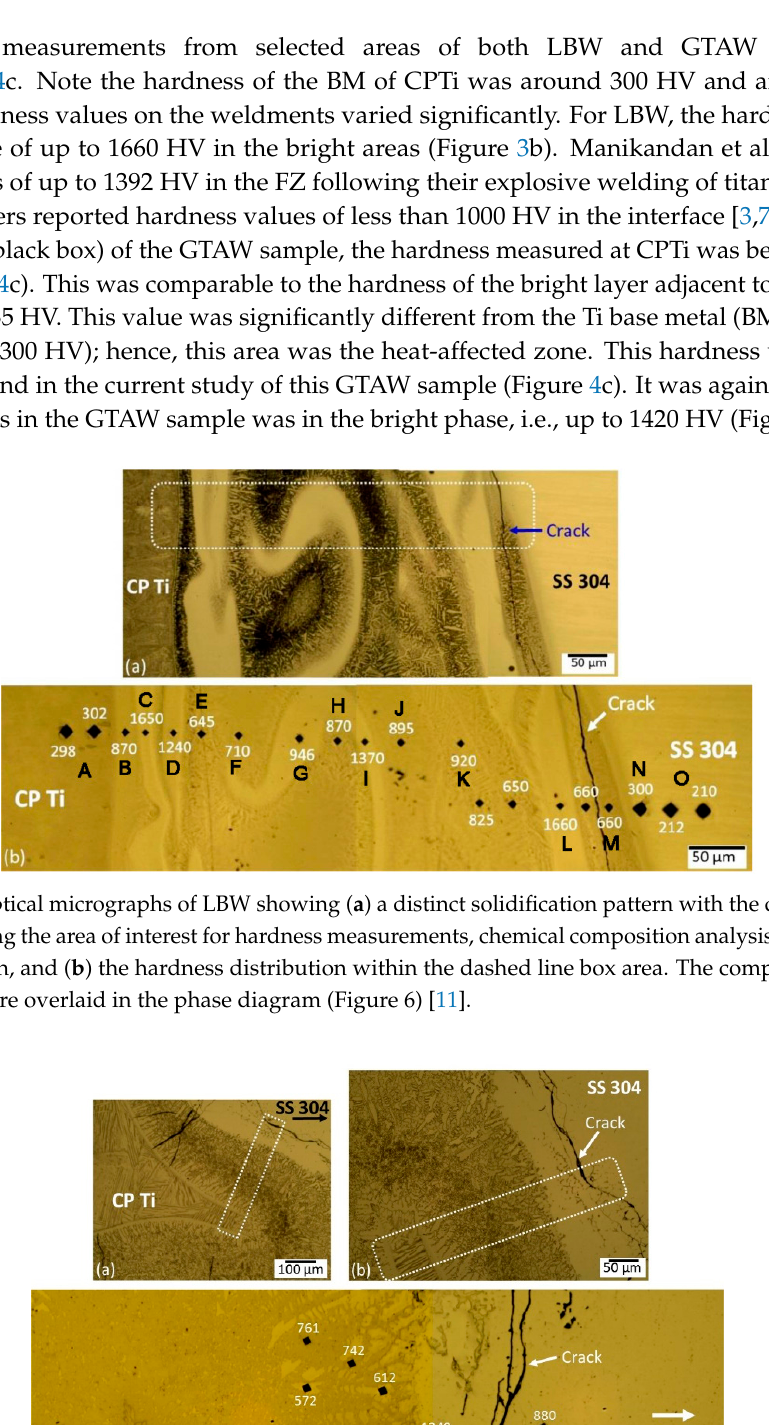
Figure 2. Low magnification optical micrographs showing weld profiles of ( a ) LBW and ( b ) GTAW. The dashed white line on ( b ) has been added to illustrate the boundary between fusion and heat- affected zones. Note: insets show schematic welding process for LBW and GTAW.